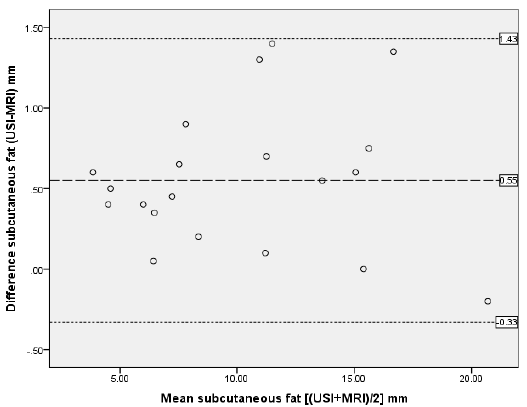
Figure 6. Bland and Altman plot showing difference between measurements of SAT thickness from MRI and US scan. The dashed line represents the mean difference; dotted lines are 95% upper and lower limits of agreement, representing two standard deviations.